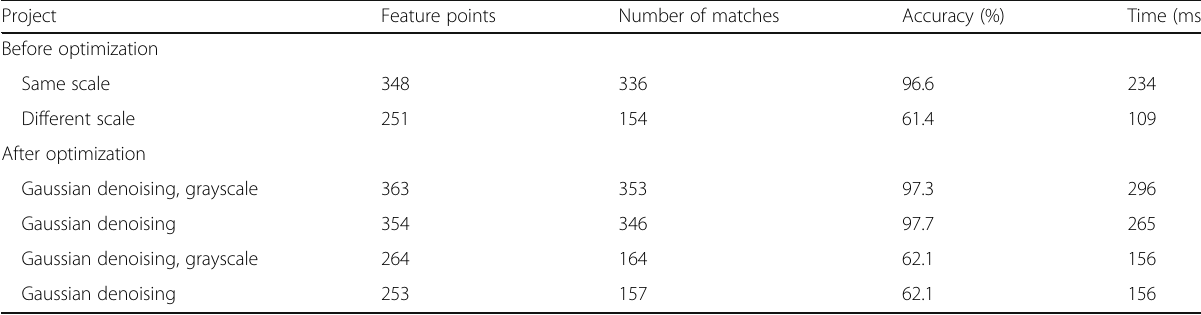
Table 9 Statistical results of experimental results before and after algorithm optimization Project Feature points Number of